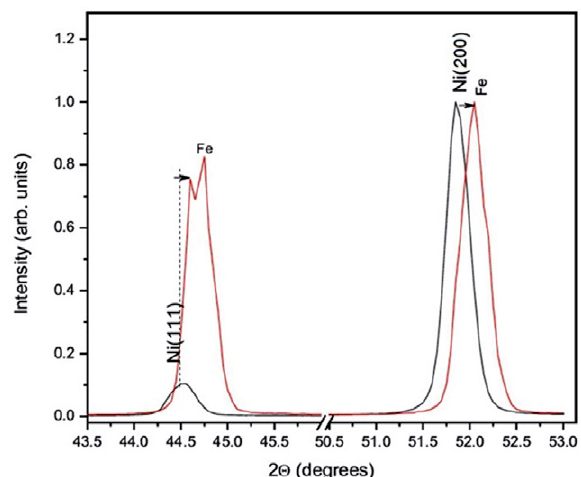
Fig. 8. The results of the XRD analysis of electrodeposited iron from 0.1 М Fe (NO 3 ) 3 × 9H 2 O + CH 2 OH-CH 2 OH electrolyte on the Ni electrode. E V = 0.02 V / s, T = 293 K.